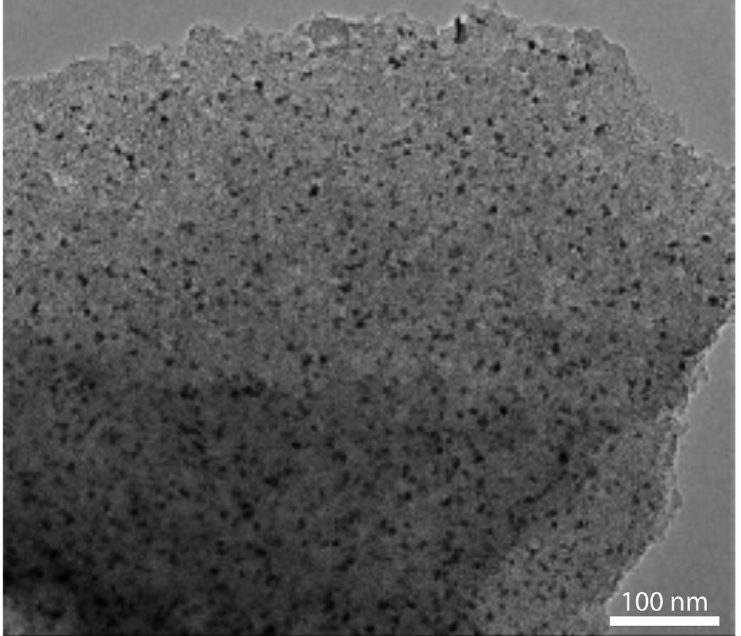
Figure 3. TEM images of ALD Pd nanoparticles supported on the AC undergoing HNO 3 etching and then calcined at 800 °C. “Reproduced with permission from [103]. American Chemical Society, 2015”. [104]). The band structure of graphene can be tailored by doping graphene with other